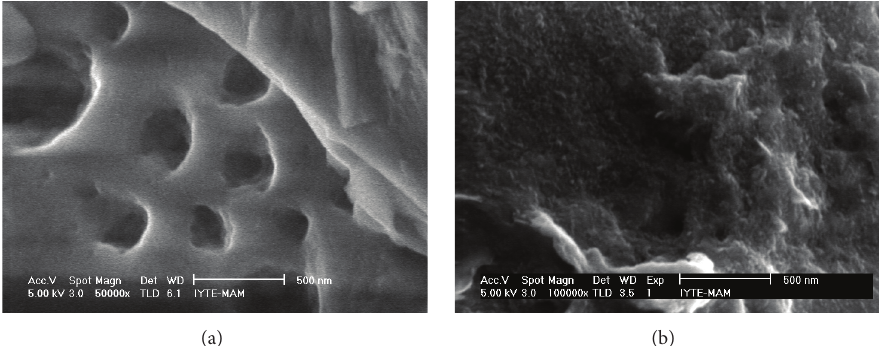
Figure 1: SEM images of uncoated/original (a) and iron oxide-coated (b) Isp pumice particles (size fraction: < 63 𝜇 m).